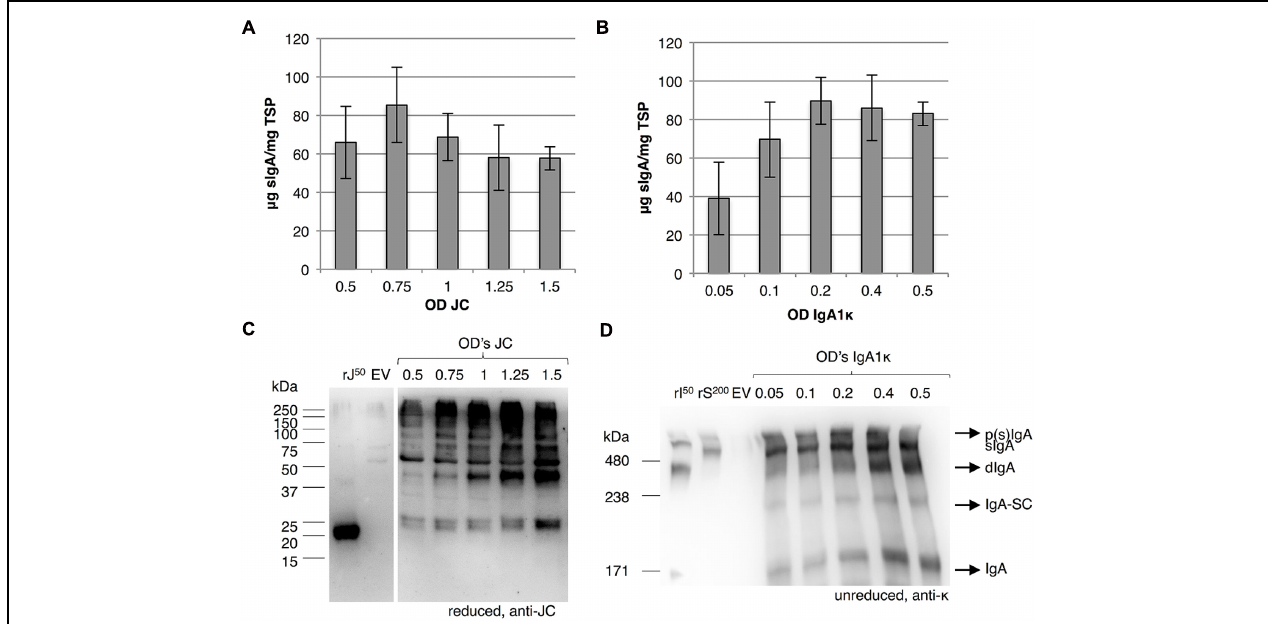
FIGURE 7 | Incorporation of the joining chain is the limiting factor for sIgA yield. Leaves were agro-infiltrated for the expression of IgA1, JC and SC by co-infiltration (vector system 3 in Figure 3B ) and harvested 6 dpi. (A) Average sIgA yield ( n = 3, error bars indicate standard error) and (B) western blot analysis upon increasing the OD of the Agrobacterium culture facilitating joining chain expression. As controls recombinant joining chain (rJ 50 ) and an EV sample were used. (C) Average sIgA yield of three biological replicates and (D) western blot analysis of sIgA assembly upon decreasing OD of the Agrobacterium culture facilitating IgA expression. As controls 50 ng of recombinant IgA1 κ (rI 50 ) and 200 ng purified sIgA (rS 200 ) and an EV sample were used.